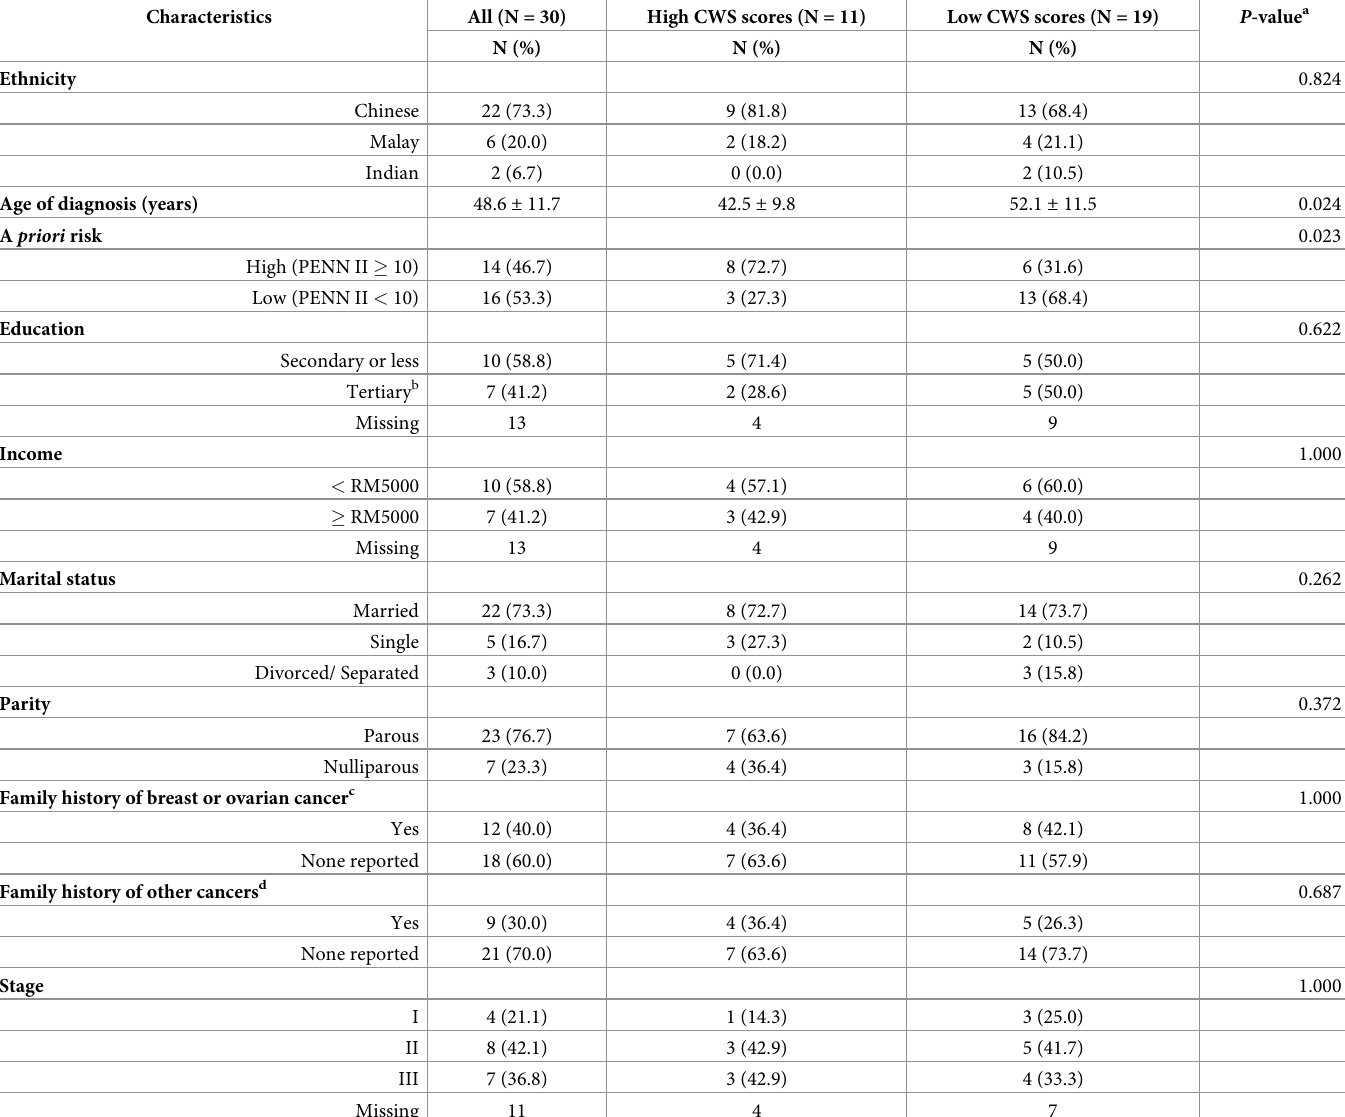
Table 2. Cancer worry scores among carriers at baseline